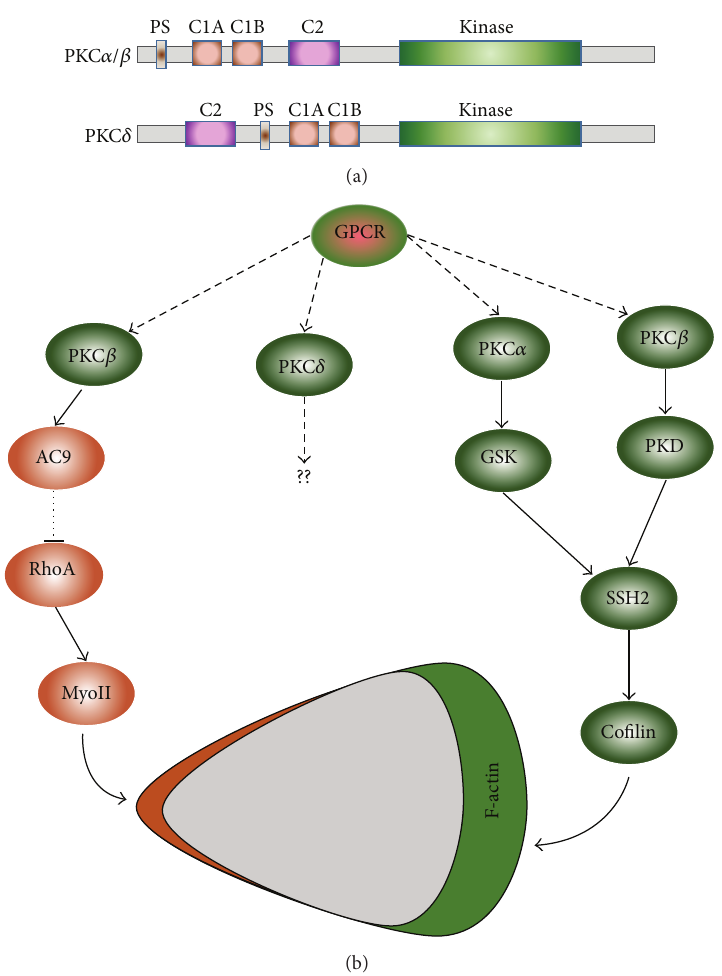
Figure 2: PKC 𝛼 and PKC 𝛽 play different roles in neutrophil polarization and chemotaxis. (a) Scheme shows the domain compositions of PKC 𝛼 , PKC 𝛽 , and PKC 𝛿 , which are expressed in neutrophils. All three PKC isoforms have an NH 2 -terminal regulatory domain that is joined through a flexible linker to a conserved COOH-terminal kinase domain that binds ATP and substrates. PKC regulatory domains contain a pseudosubstrate domain (PS) that maintains the enzyme in an inactive conformation. Membrane targeting modules (C1A-C1B-C2 domains) control the subcellular localization of the enzyme. (b) Scheme shows the signaling pathways in which PKC 𝛼 and PKC 𝛽 play essential roles in maintaining the polarization and chemotaxis of